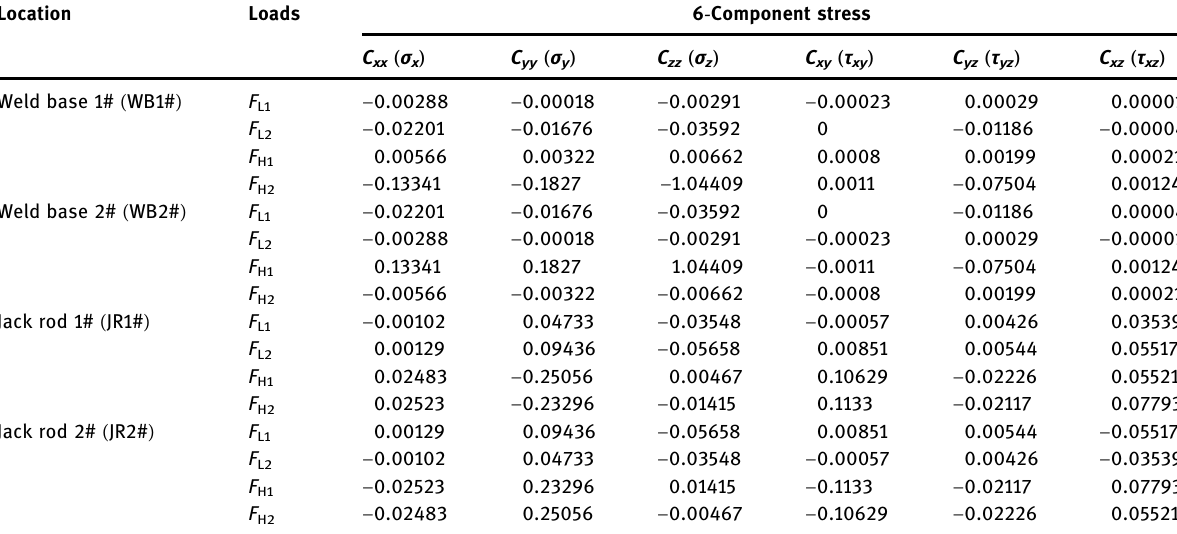
Table 2: Calculation coe ffi cient between 6 - component stress and external loads ( MPa · kN − 1 )